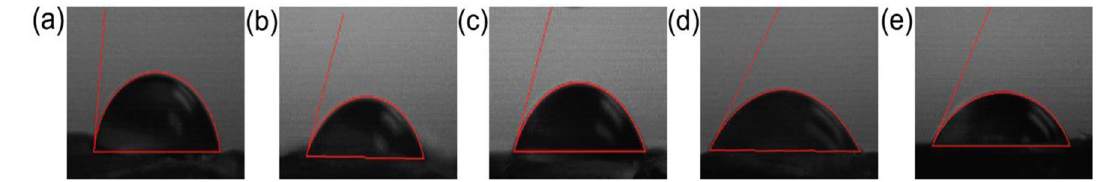
Figure 5. Surface contact angles of different electrospun nanofibers: ( a ) PVA, ( b ) PVA/EGF, ( c ) PVA/FGF ( d ) PVA/EGF/FGF(M), and ( e ) PVA/EGF/FGF(L).